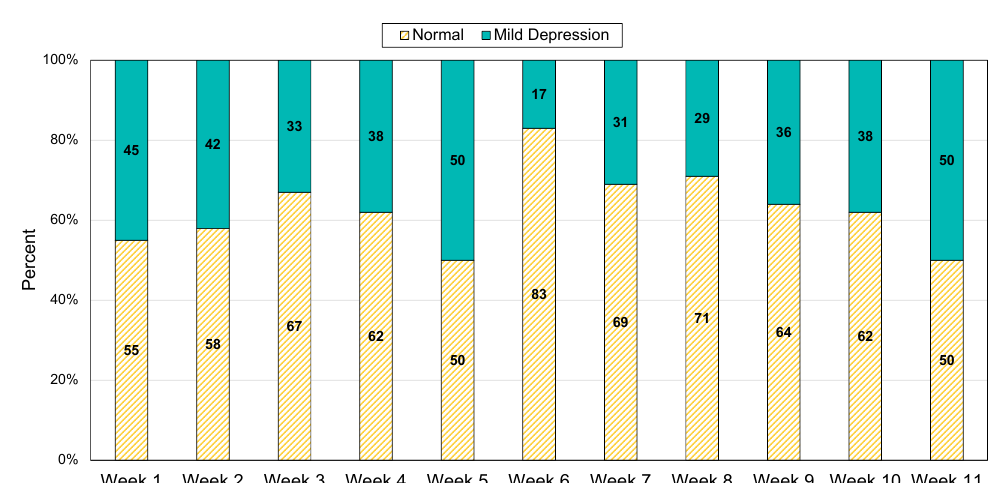
Figure 2. Weekly Ratio of Participants between Normal/Mild Depression